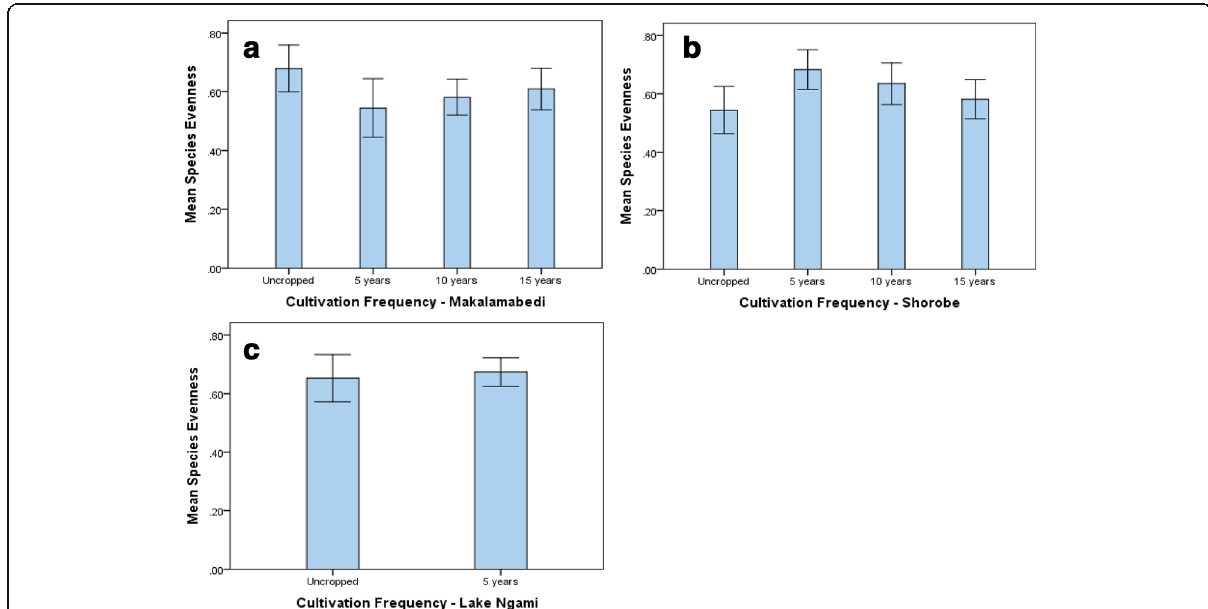
Fig. 6 Influence of cultivation frequency on species evenness within the study sites ( a Makalamabedi, b Shorobe, c Lake